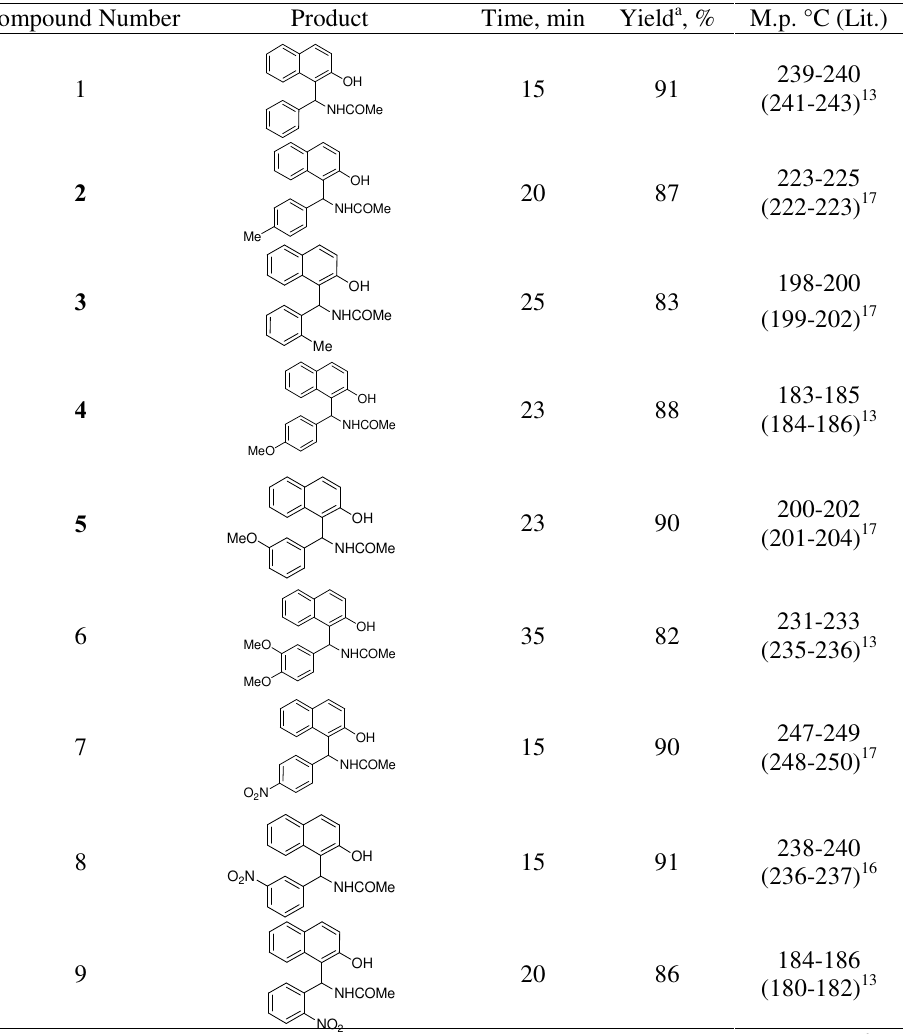
PMo O .xH O/SiO at 120 3 12 40 2 2